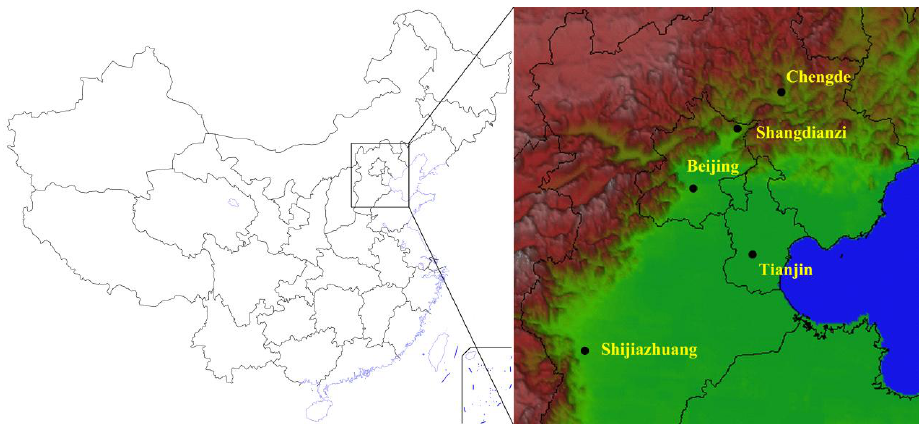
Fig. 1. Sampling sites of PM 2 . 5 Fig 1. Sampling sites of PM